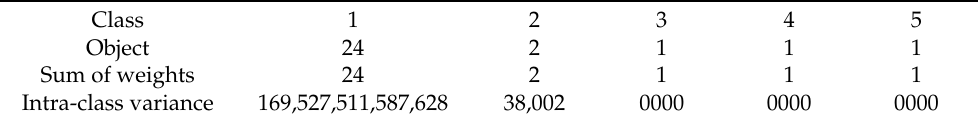
Table 2. Roads classification.